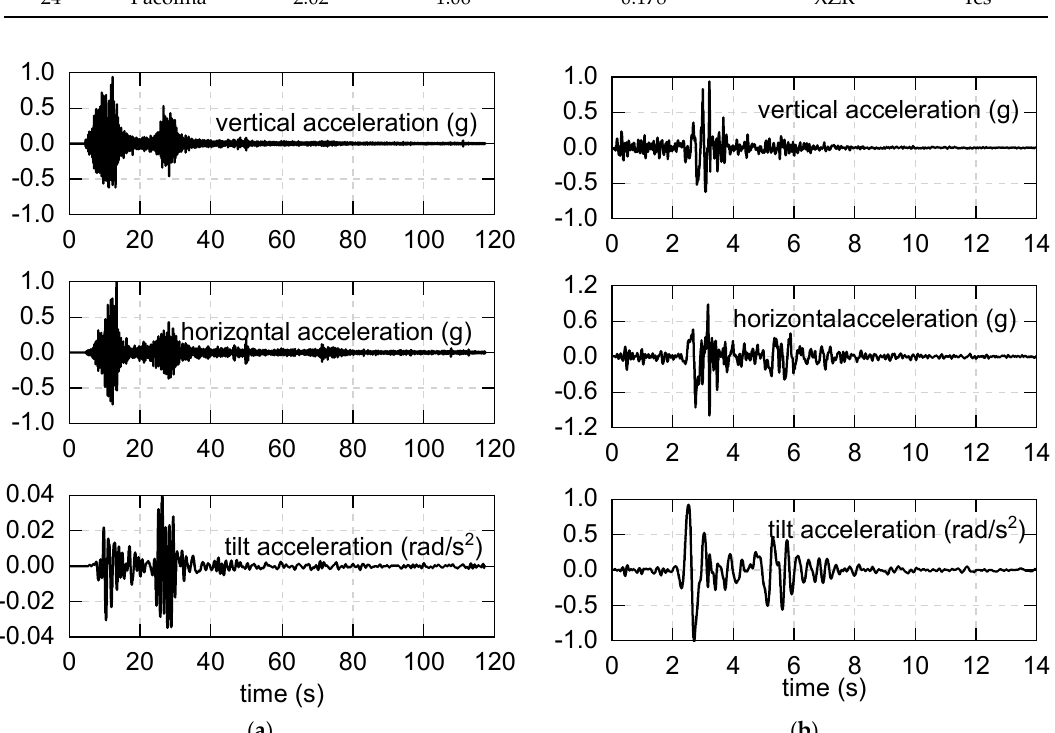
Figure 13. Pouring the asphalt into the isolation bearings: ( a ) the procedure; ( b ) the isolation bearing with asphalt.